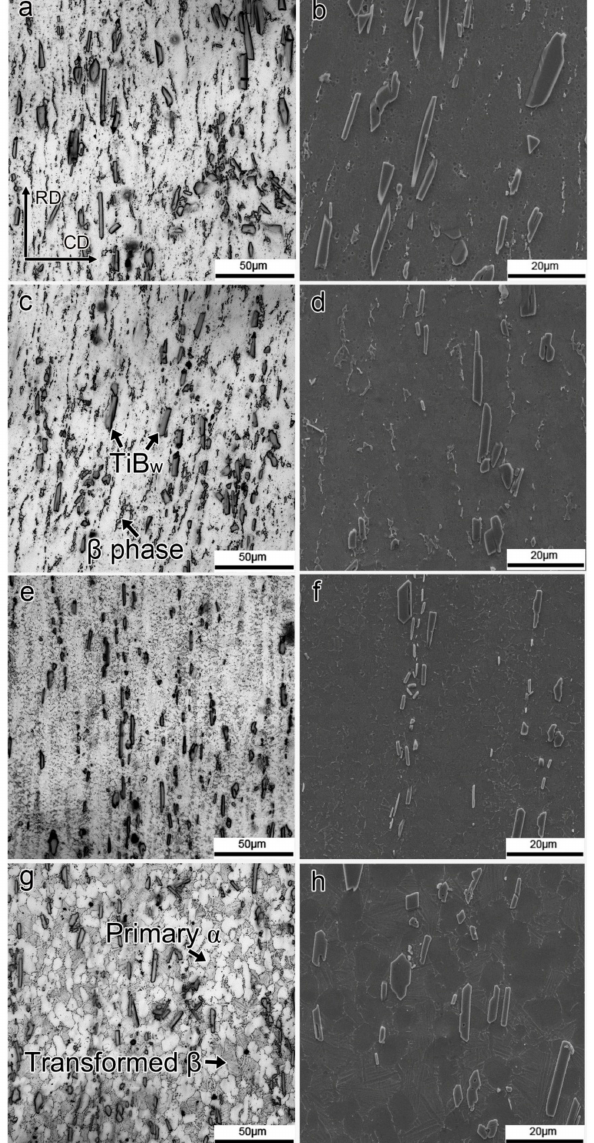
Figure 5. Microstructure of 7.5 vol.% TiB w / near α -Ti composite deformed at various temperatures: ( a , b ) 800 ◦ C, ( c , d ) 850 ◦ C, ( e , f ) 900 ◦ C, ( g , h ) 950 ◦ C. The strain rate was 0.01 s − 1 in all of the cases. CD is the compression direction, and RD is perpendicular to CD on the observation